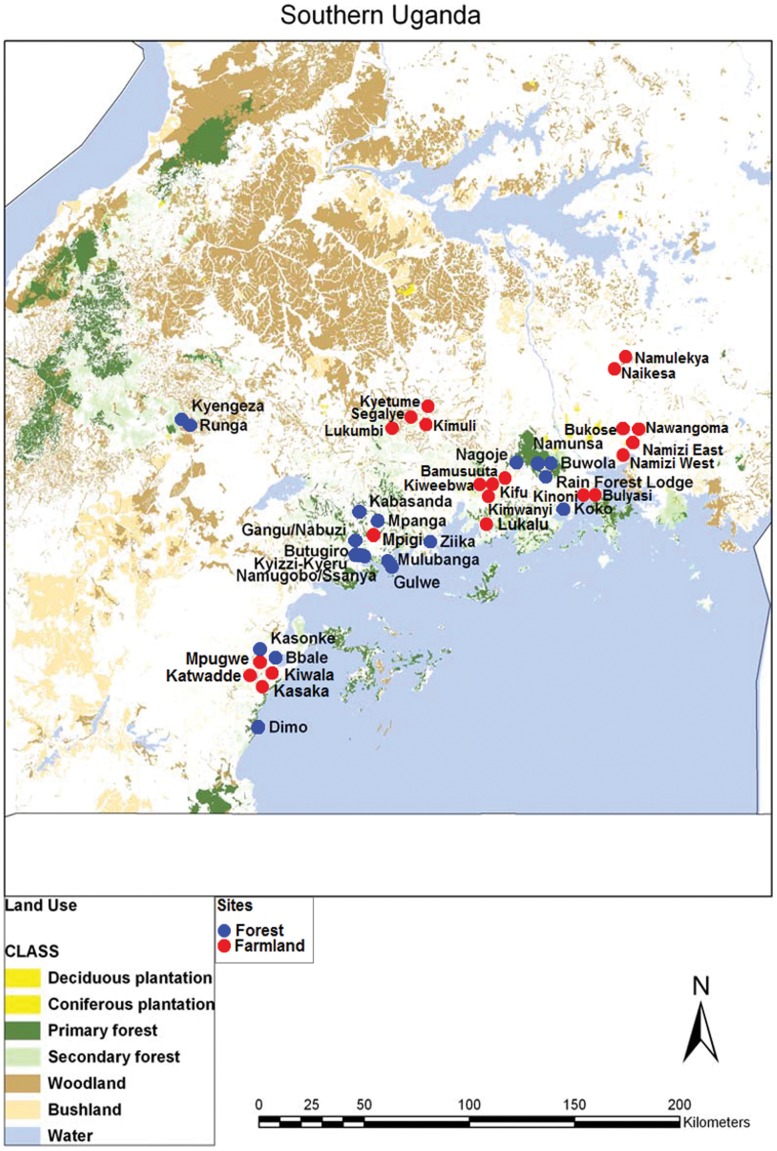
Location of study sites in Uganda.Forest sites are denoted with blue circles, farmland sites with red circles.